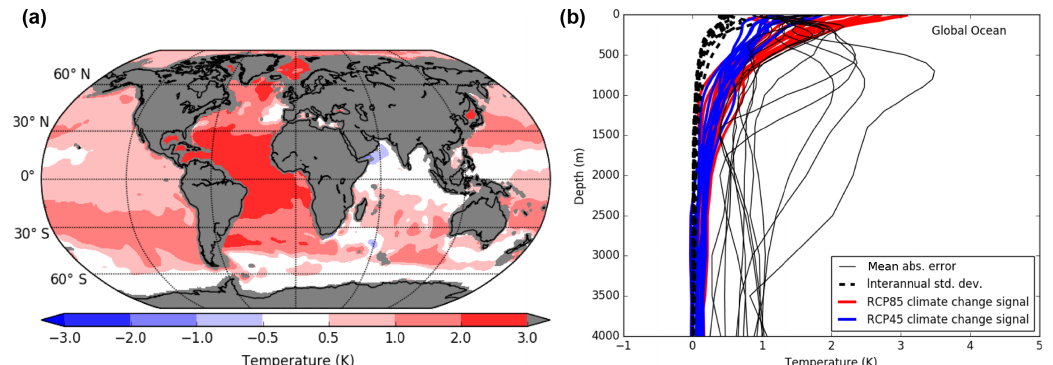
Figure 1. Biases in CMIP5 models with respect to the Polar Science Center Hydrographic Climatology (PHC 3.0, updated from Steele et al., 2001). (a) Ensemble mean DJF potential temperature bias [K] at a depth of 1000m in 13 CMIP5 historical simulations for the period 1971–2000. (b) Individual depth profiles of the mean absolute potential temperature error in the considered CMIP5 models (black lines). The interannual standard deviation [K] (dashed black lines) and the RCP4.5 and RCP8.5 climate change signal [K] (2071–2100 minus 1971–2000; blue and red lines) are given for